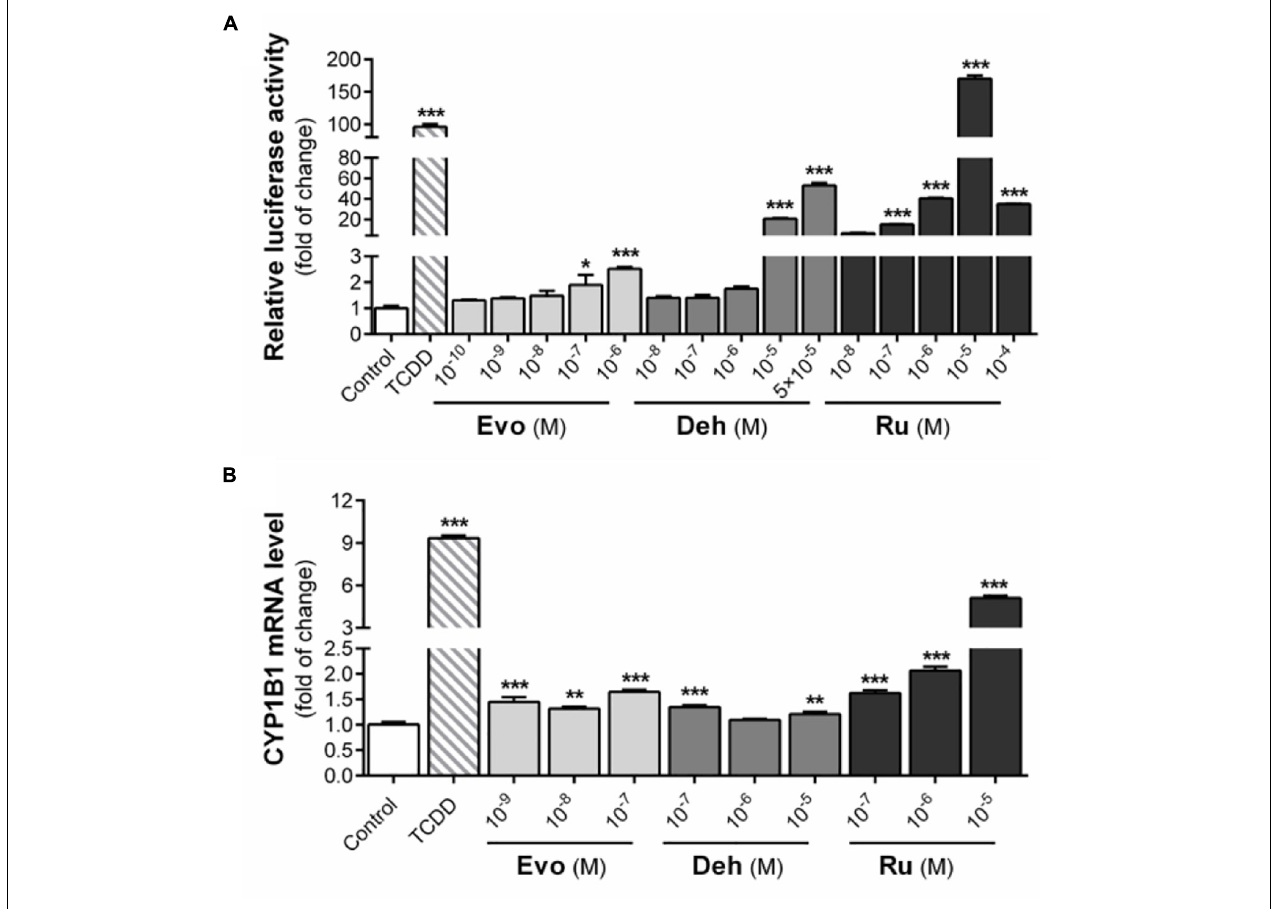
FIGURE 2 | Activation of AhR signaling pathway by three bioactive substances in Evodia rutaecarpa . (A) Effect of evodiamine, dehydroaevodiamine, and rutaecarpine on activation of AhR after 24 h treatment was determined by luciferase reporter assay in CBG2.8D cells. (B) Effect of evodiamine, dehydroaevodiamine, and rutaecarpine on the mRNA expression of CYP1B1 in U87 cells after 48 h treatment were determined by qPCR analysis. GAPDH was used as an internal control for quantification. * p < 0.05, ** p < 0.01, *** p < 0.001 compared with control group. All values are fold of control that was treated with the solvent and represent the mean ± SEM ( n = 3). SEM, standard error of the mean; Evo, evodiamine; Deh, dehydroaevodiamine; Ru,